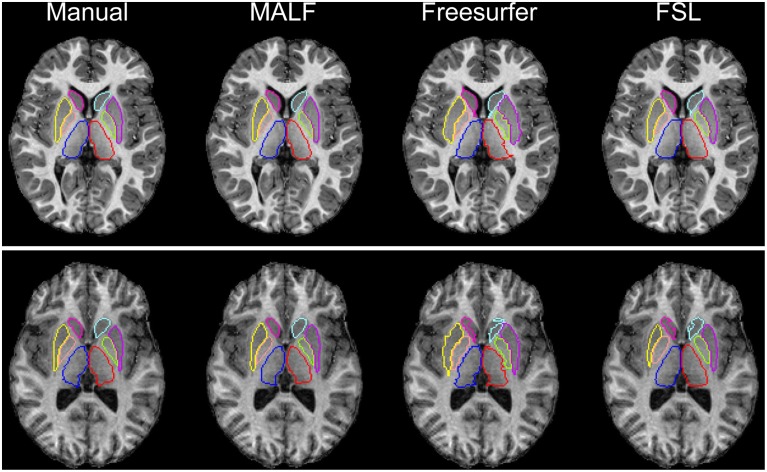
The top and bottom panels show segmentation results of the six basal ganglia structures (left and right caudate, putamen, and globus pallidus) and the bilateral thalamus in an individual subject of the first dataset (30 pediatric subjects), different for each panel. From left to right, segmentations are obtained from manual delineation, MALF, Freesurfer, and FSL.